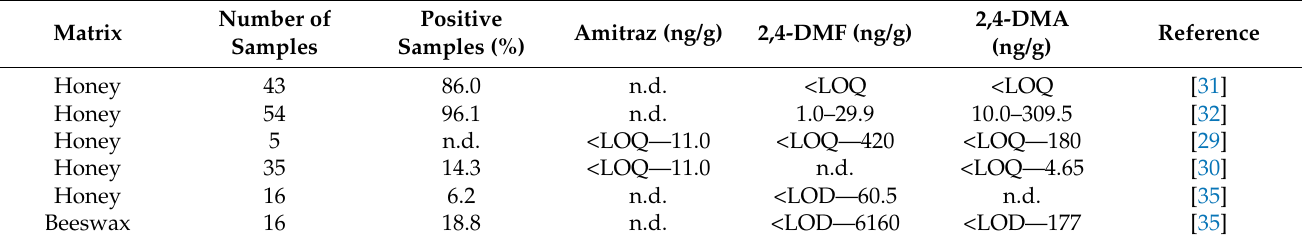
Table 4. Concentrations of amitraz and its metabolites in honey and other